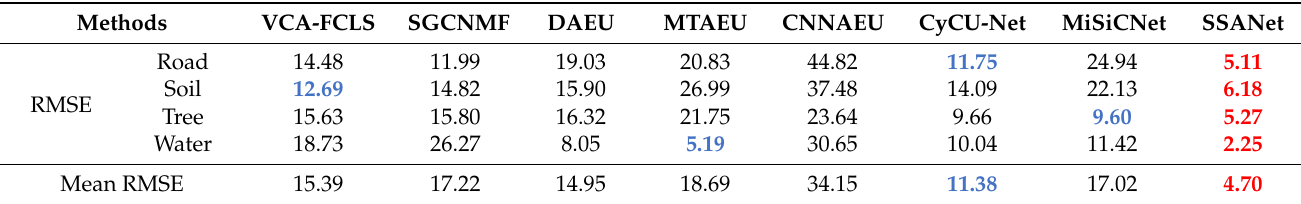
Table 4. RMSE ( × 100) and mean RMSE ( × 100) of abundances acquired by various unmixing approaches on Jasper Ridge data. Annotation: bold red text indicates the best results and bold blue text indicates the suboptimal results.